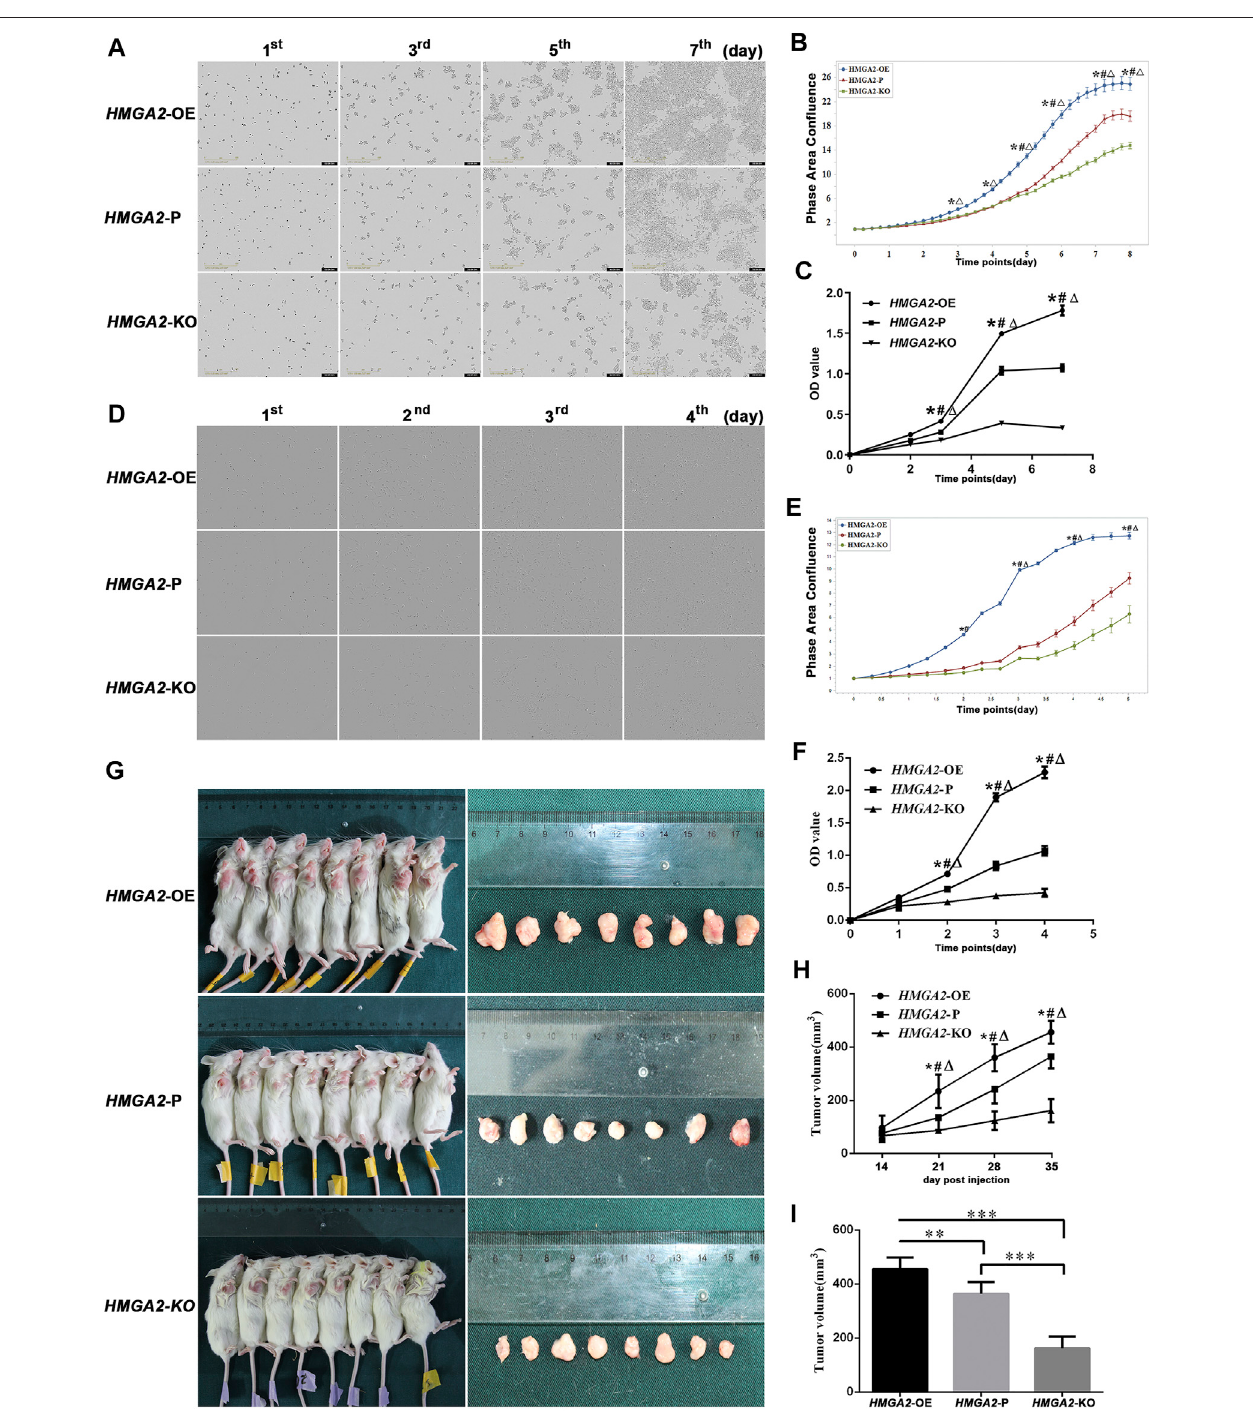
FIGURE 2 | HMGA2 promotes the proliferation of the GC cells in vitro and in vivo . (A) Growth comparison of HMGA2 -edited MKN-45 cells. The images in the vertical lines are the cell proliferation at different time ( fi rst, third, fi fth, and seventh days). The pictures in the horizontal lines mean different groups: upper , HMGA2 -OE cells; middle , HMGA2 -Pcells; bottom , HMGA2 -KOcells. (B) Continuous proliferationrecordsof HMGA2 -editedMKN-45cells via IncuCyteS3.Abscissa:consecutive days;ordinate:phaseareacon fl uence.Thephaseareacon fl uencesoftheinitialseededcellsindifferentgroupsweresetas1,respectively.Bluecurve: HMGA2 -OE cells; red one: HMGA2 -P cells; green one: HMGA2 -KO cells. (C) MTT assay to detect the growth of HMGA2 -edited MKN-45 cells. X -axis: different days of cell viability; Y -axis: OD value. (D) Growth comparison of HMGA2 -edited MGC-803 cells. Vertical lines: different time ( fi rst, second, third, and fourth days); horizontal lines: upper , HMGA2 -OE cells; middle , HMGA2 -P cells; bottom , HMGA2 -KO cells. (E) Continuous proliferation records of HMGA2 -edited MGC-803 cells via IncuCyte S3.